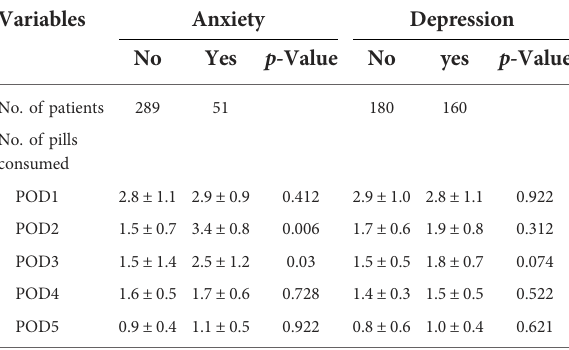
TABLE 3 The amount of oral analgesic consumed by the patients during hospital stay after surgery.